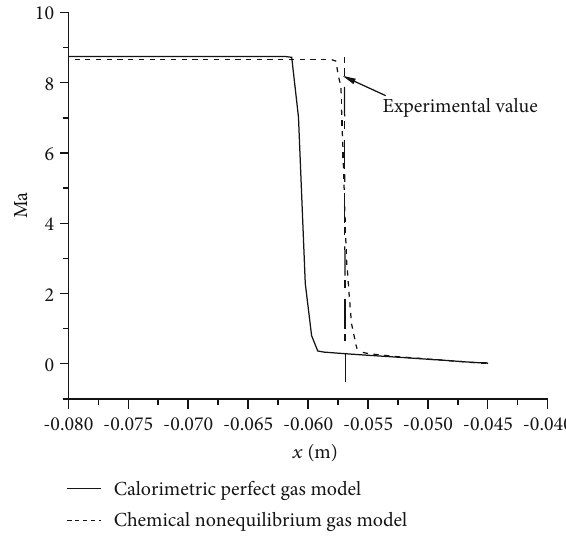
Figure 7: Distribution of the Mach number along a stationary